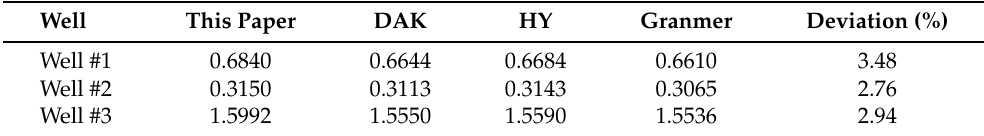
Figure 6. The effect of different CO 2 contents in the natural gas system on the dynamic reserves calculation among the four empirical methods by the material balance method. Table 4. Well-controlled dynamic reserves of three wells by using the material balance method where the unit is 10 8 m 3